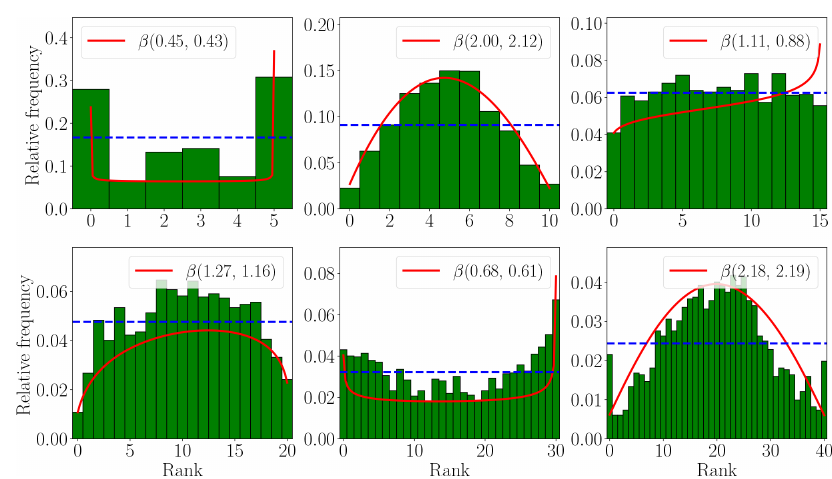
Figure 14. Rank histograms with fitted beta distributions. The KL-divergence measure is indicated under each panel. Table 5. Measures of uniformity of the rank histograms shown in Fig. 14. Panel 1 2 3 4 5 6 D KL (β | U ) 0.198 0.231 0.022 0.018 0.065 0.272 Average distance to U 0.085 0.038 0.005 0.011 0.008